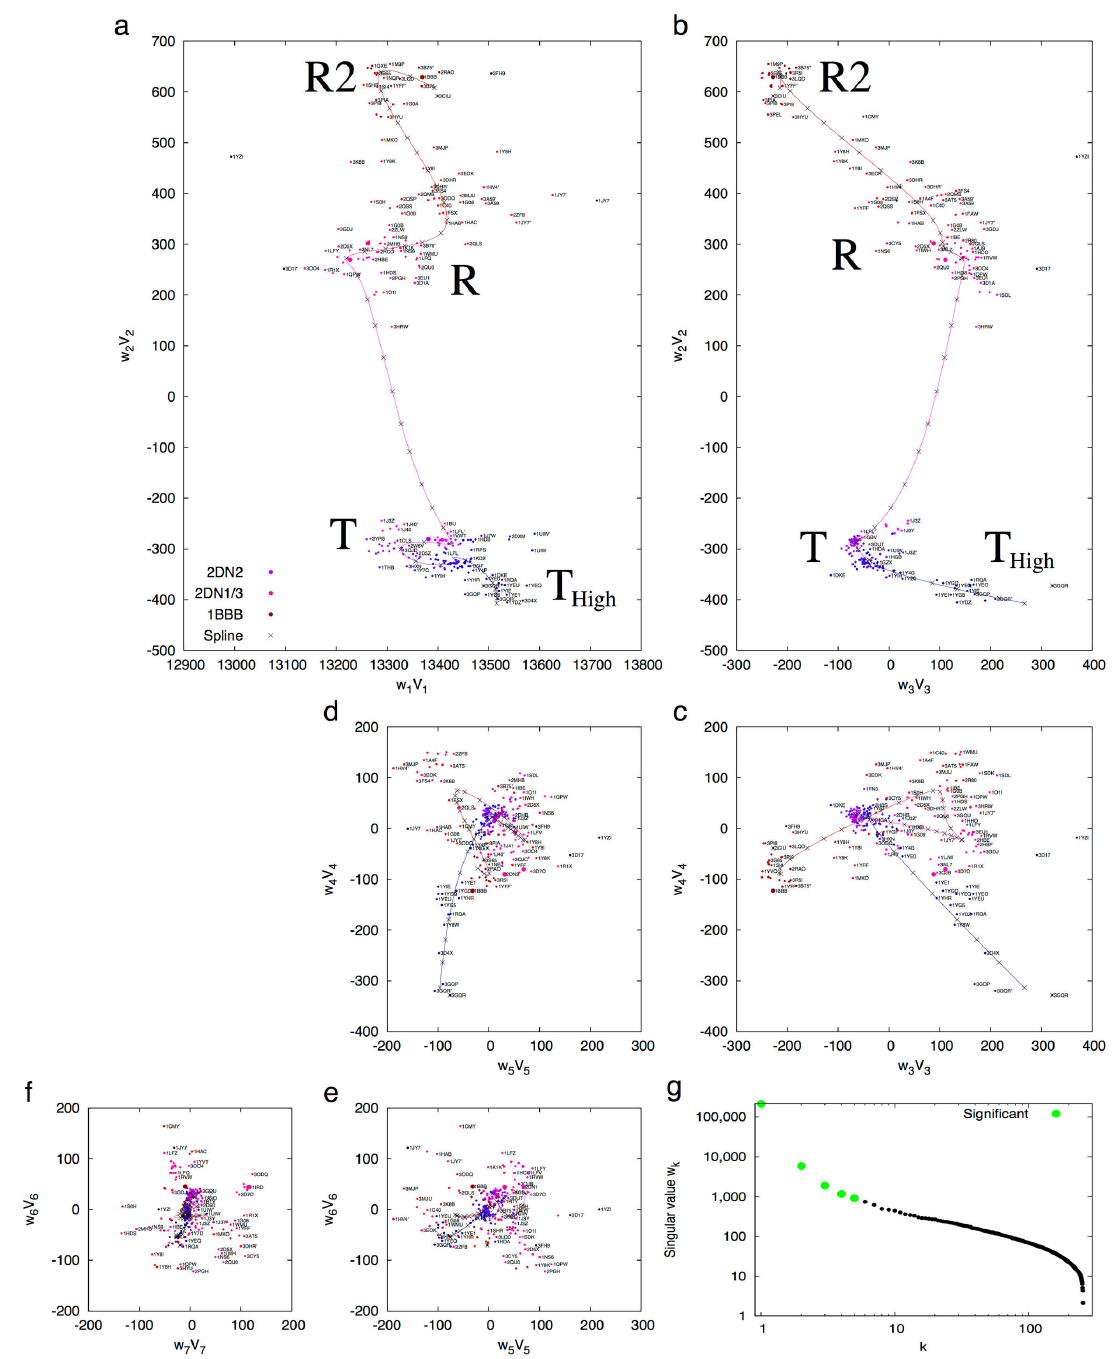
Figure 2. The first seven dimensions of Hb conformational space. The coefficient sets w V with k = 1, …, 7 derived from SVD k k analysis of 280 tetrameric structures are plotted in a - f . Each pair of consecutive panels can be considered as two orthogonal planes by folding 90° along a line between them. The deoxy Hb 2DN2 is in blue. The oxy (2DN1) and carbonmonoxy (2DN3) forms of Hb are in red. The R2 state 1BBB is in dark red. Others are in continuous color transition from dark blue to blue to purple to red to dark red along the trajectory as a traveling salesman solution. PDB entries are labeled by small typeface whenever possible, and are only visible on a digital copy. The smooth trace through the multidimensional space is a spline fit to the traveling salesman solution that suggests a plausible reaction pathway T -T-R-R2. Evenly spaced sampling points along the spline are marked by ×. High The singular values w are plotted in g with the first five significant ones in green. k doi: 10.1371/journal.pone.0077141.g002 PLOS ONE |